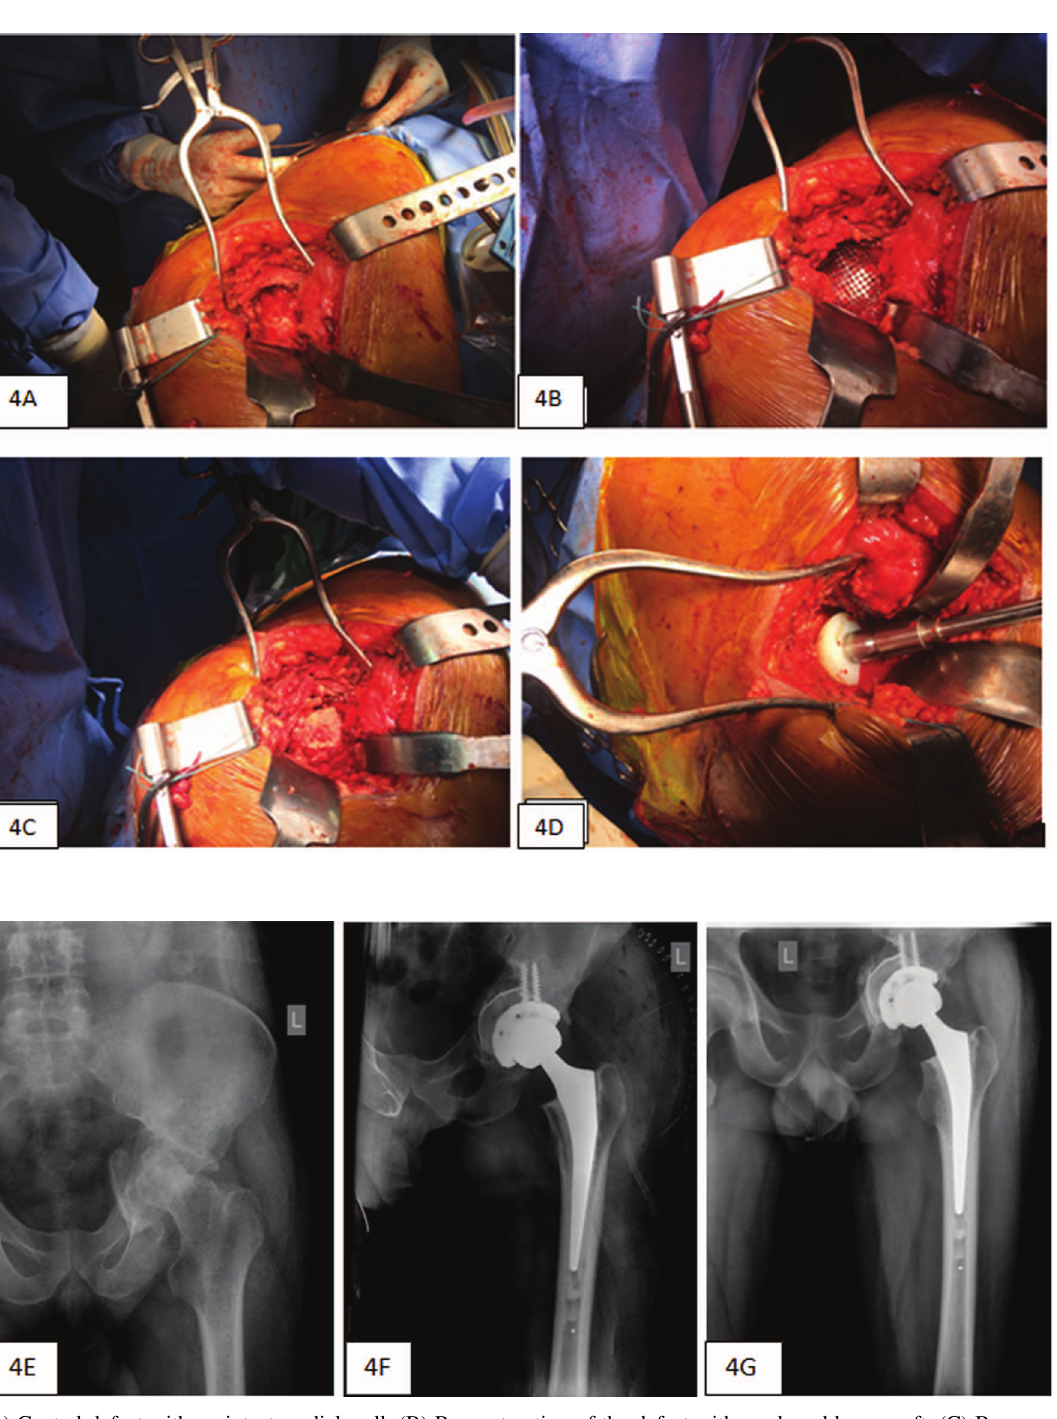
Figure 4. (A) Central defect with no intact medial wall. (B) Reconstruction of the defect with mesh and bone graft. (C) Bone graft over the mesh. (D) Impaction. (E) Radiograph showing a medial wall defect. (F) Radiograph showing medial wall reconstruction with mesh and bone graft. (G) Well-consolidated bone graft at 5-years